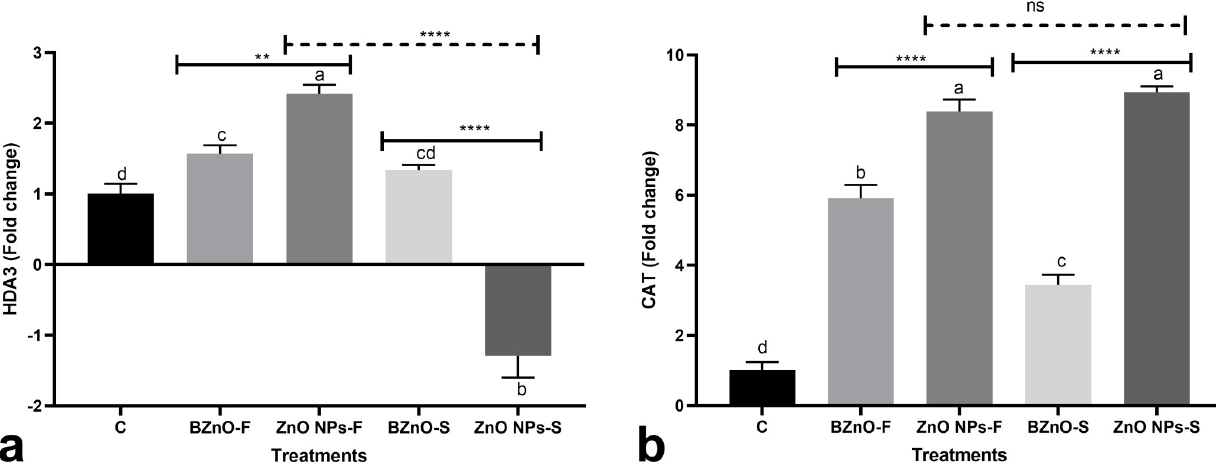
Fig 2. The transcriptional responses of HDA3 [a] and CAT [b] genes following the BZnO or ZnONP treatments. The treatment groups: C: Control; BZnO-F: Foliar application of BZnO; ZnO NPs-F: Foliar application of ZnO NPs; BZnO-S: Supplementation of nutrient solution with BZnO; ZnO NPs-S: Supplementation of nutrient solution with ZnO NPs; Different letters on the columns refer to statistically significant differences according to Tukey’s multiple comparisons test. A comparison between the two BZnO and ZnO NPs groups at the same method is presented by placing an asterisk [ � ] on the line, while asterisks [ � ] on the dashed lines define the comparison between two ZnO NPs-F and ZnO NPs-S groups. ns: Non-significant; � : 0.01 < p � 0.05; �� : 0.001 < p � 0.01; ��� : 0.0001 < p � 0.001; ���� : p � 0.0001.